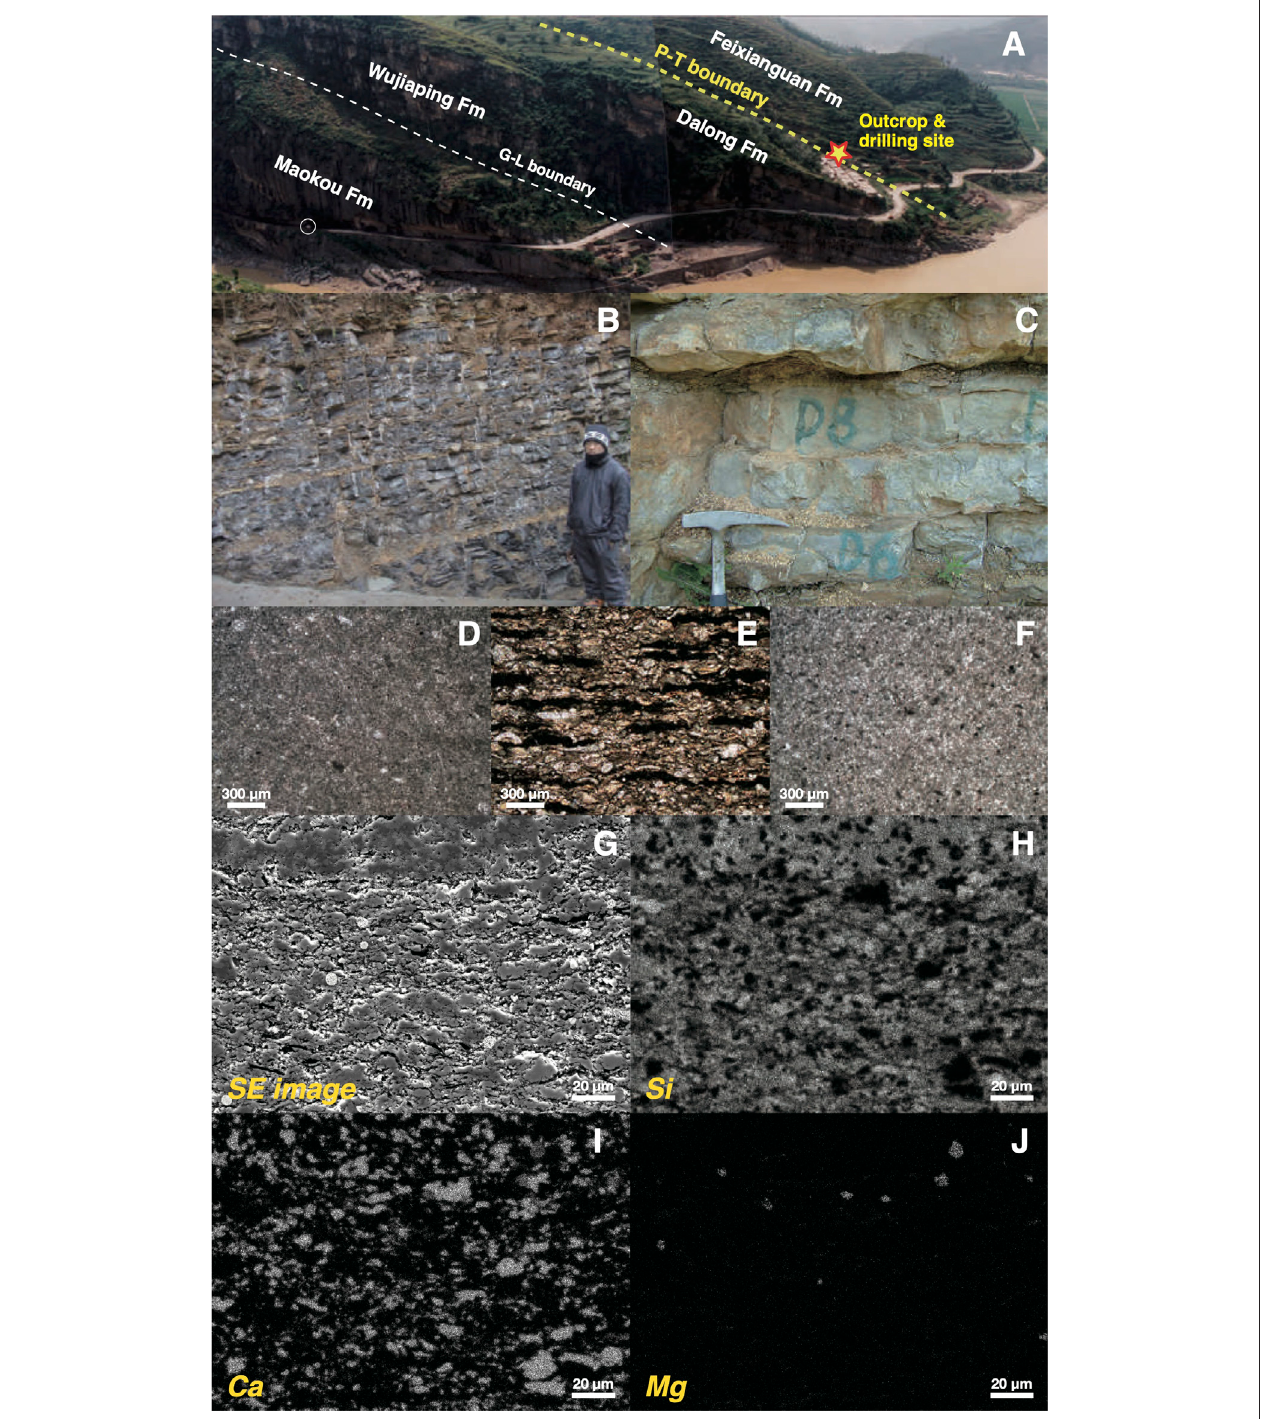
FIGURE3| Adistantviewand photographs oftheP-TB intervalat Chaotian. (A) AdistantviewofChaotian (circled carforscale). (B,C) Outcropsoftheuppermost Dalong limestones. (D – F) Thin sections of bioclastic limestone in the upper Wujiaping Formation (D) , calcareous mudstone in the Dalong Formation (E) , and lowermost Feixianguan limestone (F) . (G-J) Secondary electron (SE) image (G) and element maps (H – J) of calcareous mudstone in the Dalong Formation. Carbonates in the mudstones are mainly fi nely-fragmented bioclasts with few secondary dolomites.